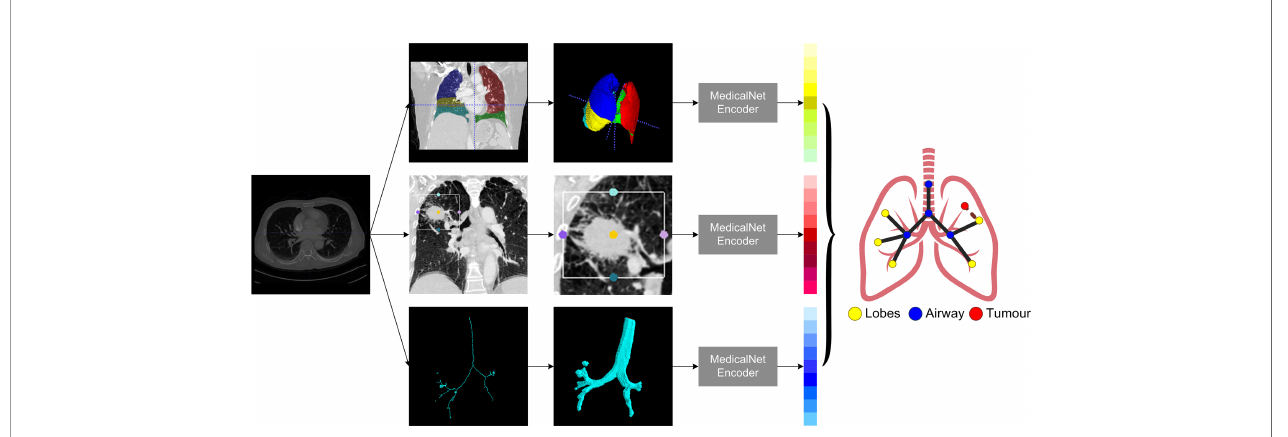
FIGURE 2 | The pipeline of building patients ’ lung